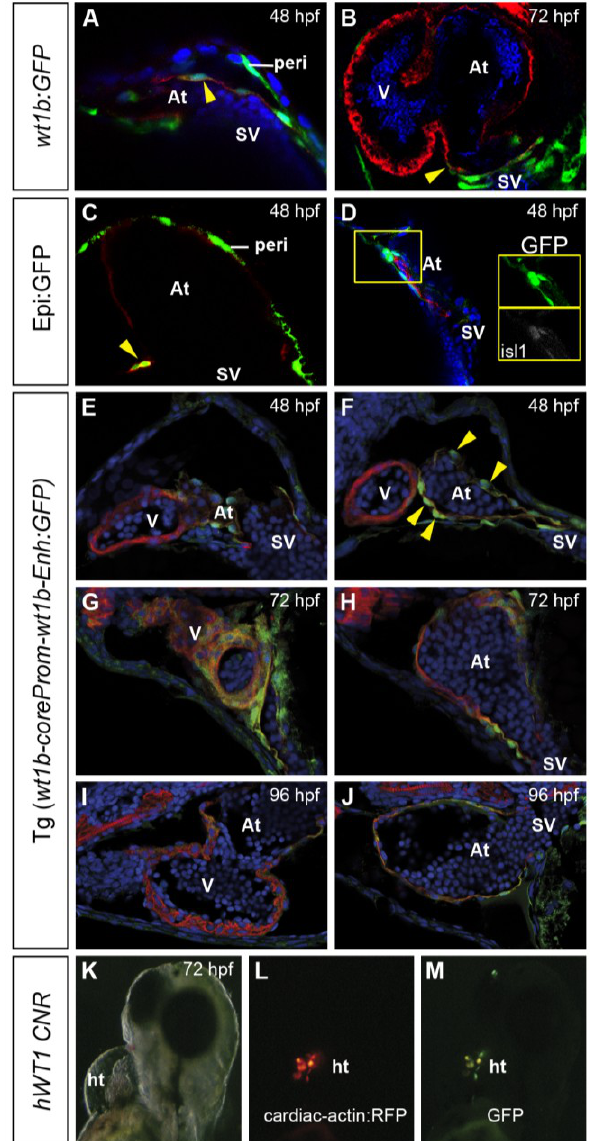
Figure 3. Partial coexpression of GFP and myocardial marker genes in wt1 transgenic lines. Immunofluorescence on sections of different wt1 transgenic lines at stages are indicated in the panels, revealing GFP expression in green and myosin heavy chain (MHC) expression in red, except in panel A, in which red reveals myh6 expression. Cell nuclei are counterstained in blue. Arrowheads mark cells coexpressing GFP and a cardiomyocyte marker. ( A and B ) wt1b:GFP at 48 and 72 hpf, showing GFP-positive myocardial cells close to the venous pole. ( C ) Coexpression of Epi:GFP with myh6 in atrial cardiomyocytes close to the venous pole. ( D ) Coexpression of Epi:GFP with islet 1 (isl1) at the venous pole of the heart. ( E – J ) Tg( wt1b-coreProm-wt1b-Enh:GFP ) embryos expressing GFP in the atrial myocardium. ( K – M ) Brightfield and fluorescence views of a transient transgenic larva expressing GFP under the control of a conserved human WT1 noncoding genomic region (CNR) and expressing red fluorescent protein (RFP) under the control of a myocardial promoter. Note the cells coexpressing GFP and RFP. At, atrium; ht, heart tube; hpf, hours postfertilization; peri, pericardial mesothelium; SV, sinus venosus; V,